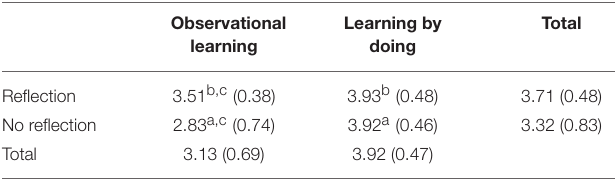
TABLE 8 | Satisfaction scores (SD) in relation to Instructional Method and Reflection (min. score 0, max. score 5).